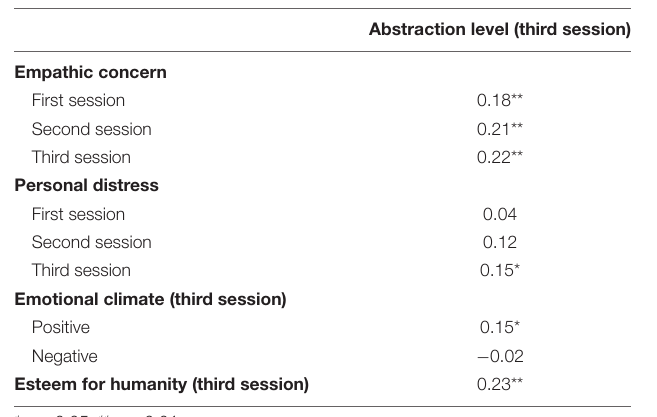
TABLE 2 | Correlations between abstraction and measures ( N = 253).